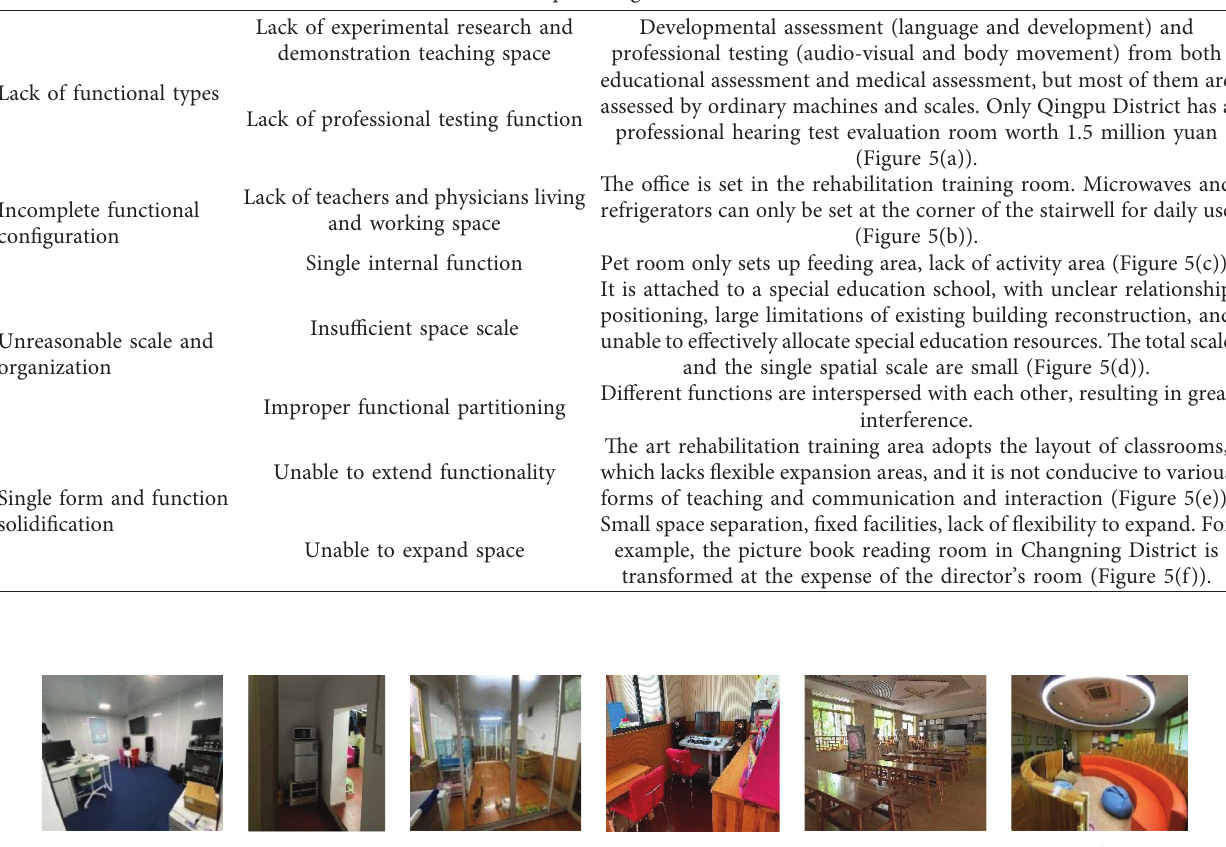
Table 1: Space usage status issues.